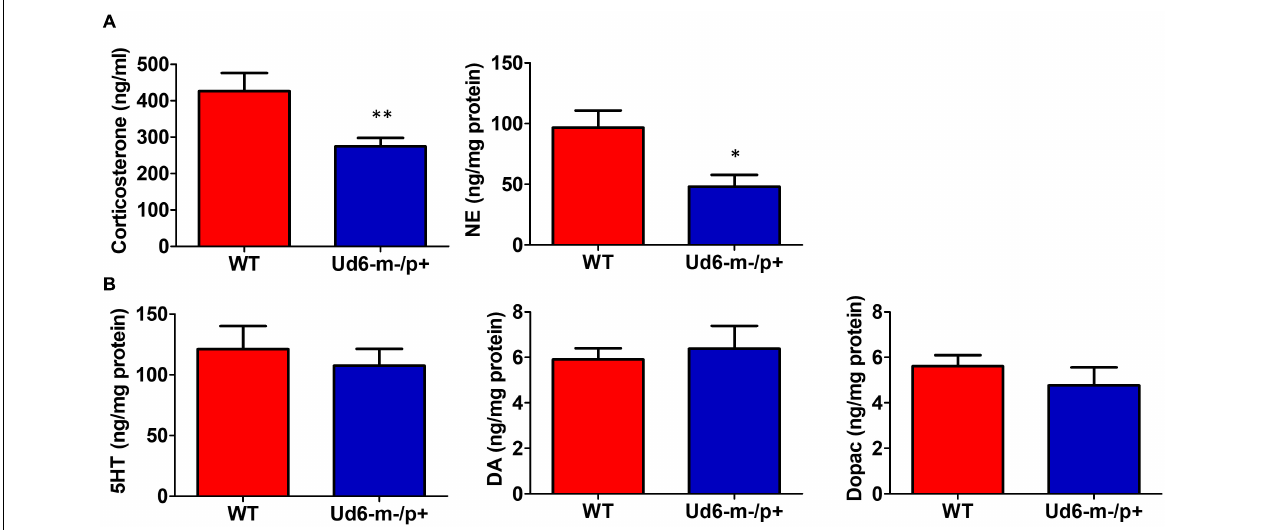
FIGURE 7 | Reduced anxiety and stress hormones in Ud6-m-/p+ mice. (A) Serum corticosterone and norepinephrine (NE) concentration in the hypothalamus collected at ZT10-12 are decreased in Ud6-m-/p+ mice. Data are plotted as mean ± SEM, ∗ p < 0.05 and ∗∗ p < 0.01 by two-tail unpaired T test. WT: N = 6, Ud6-m-/p+: N = 10. (B) 5-HT, DA, and Dopac contents are not significantly different in the hypothalamus of Ud6-m-/p+ mice as compared with WT mice. Data are plotted as mean ±